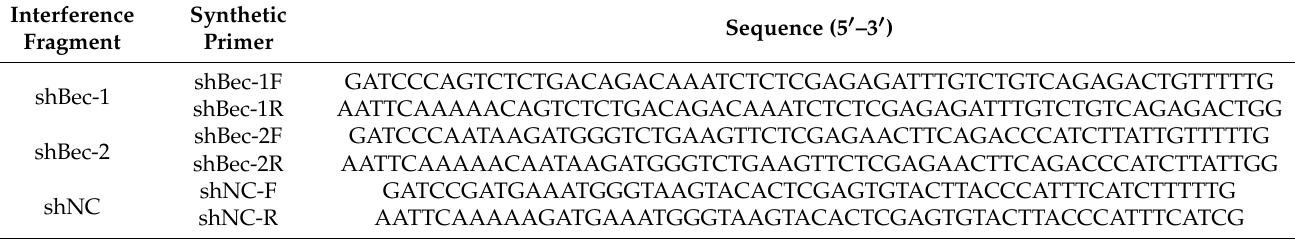
Table 1. Sequences of shRNAs.